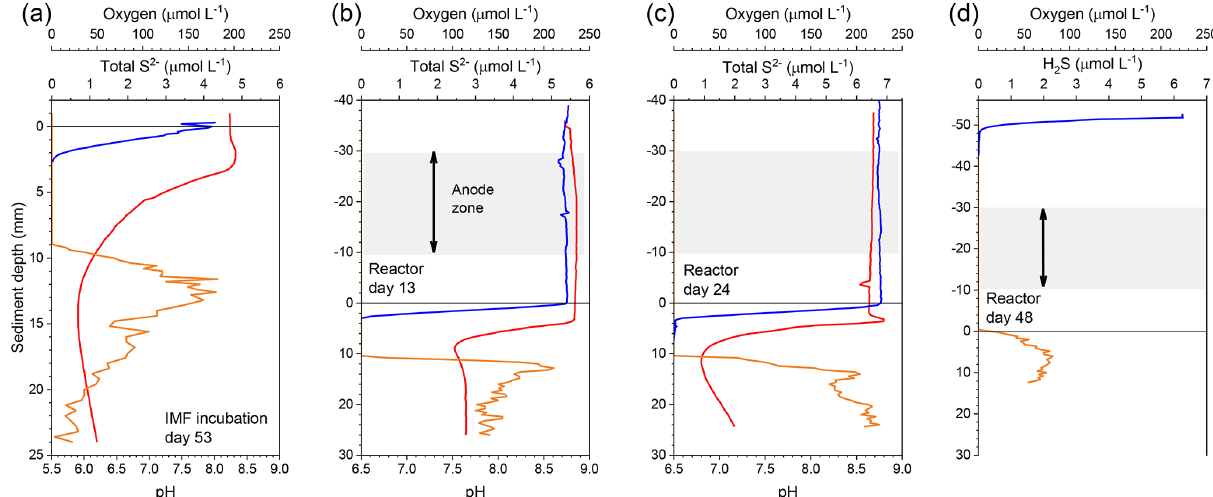
Figure 2. Representative microelectrode depth profiles of oxygen (blue), pH (red), and (cid:54) H 2 S or H 2 S (yellow) in (a) IMF sediment after 53d of incubation and in the bioelectrochemical reactor at (b) day 13, (c) day 24, and (d) day